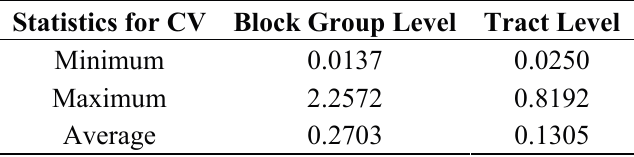
Table 3. Summary of statistics of the coefficient of variation (CV) for the variable median family income from ACS at the census block groups and tracts